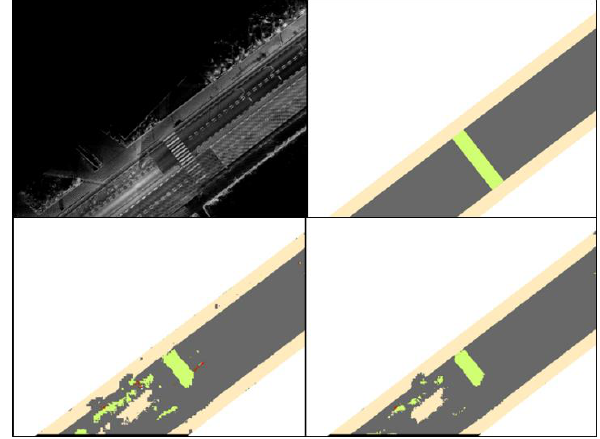
Figure 10. Example of our labeling results. Upper left: input image. Upper right: ground truth label. Lower left: only 48×48 pixels. Lower right: combination of 64×64 pixels and 48×48